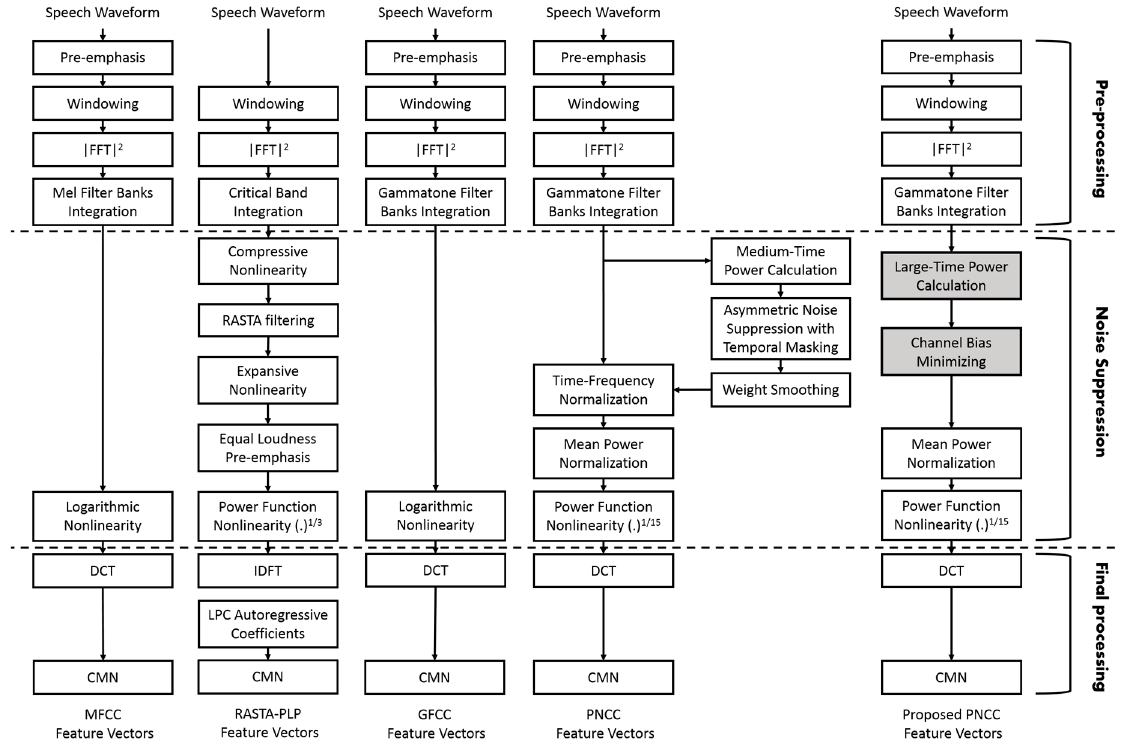
Figure 1. Di ff erence between the block diagrams of enhanced PNCC, PNCC, GFCC, Figure 1. Difference between the block diagrams of enhanced PNCC, PNCC, GFCC, RASTA–PLP,